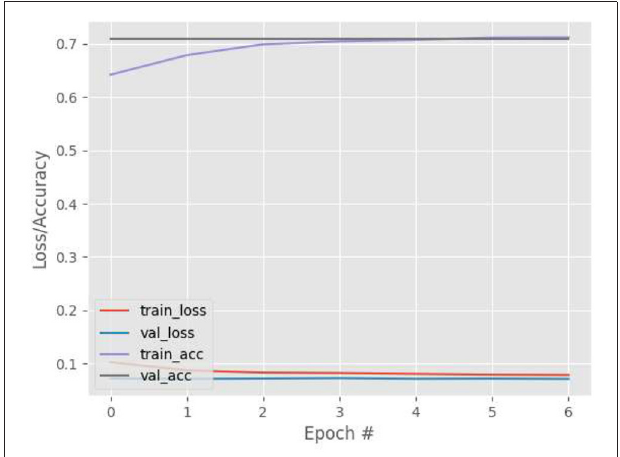
FIGURE 12 | Results for FL + on TabletGaze dataset.